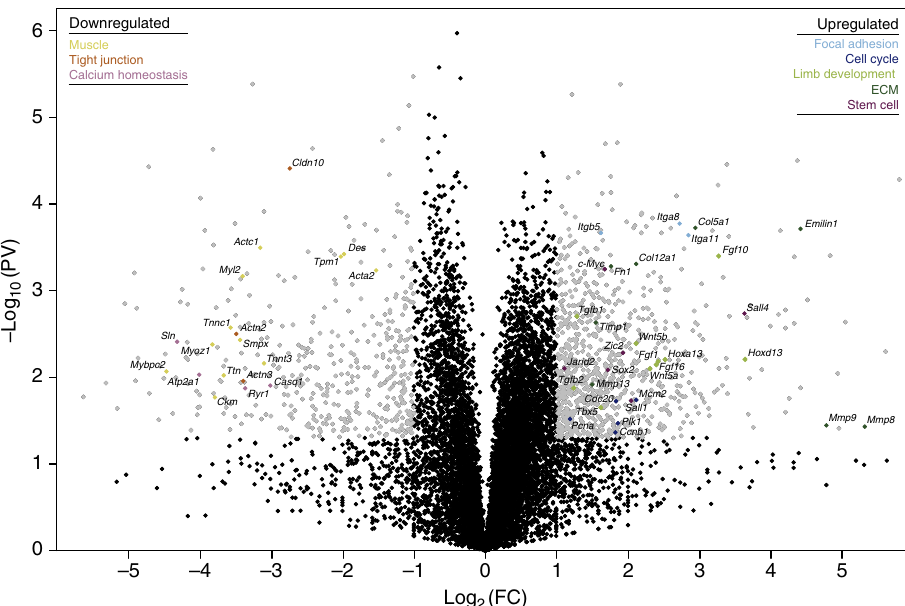
Figure 2 | The genetic basis of lungfish fin regeneration. Volcano plot showing differentially expressed genes between NRF tissue and 3 wpa FB. In a volcano plot, each dot represents a gene. Black dots are either below Student’s t -test P value ( o 0.05) or fold change ( 4 2) cutoffs. Grey dots are within established limits of P value and fold change. Key genes are shown colour coded according to eight categories: muscle, tight junction, calcium homeostasis, focal adhesion, cell cycle, limb development, ECM and stem cell. Fold change displayed in a log 2 scale and P values in (cid:2) log 10 . PV, P value; FC, fold